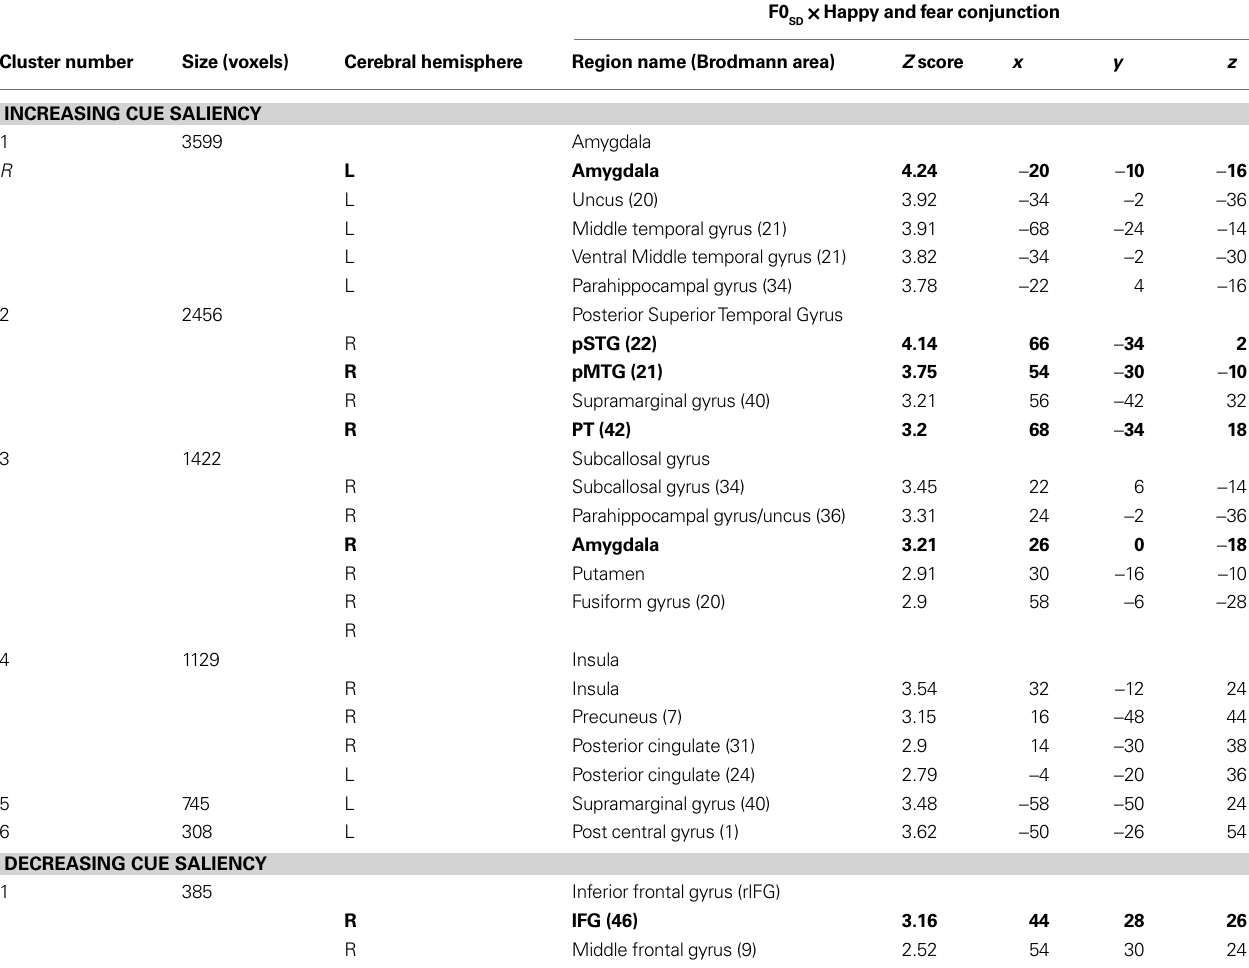
× Happy and fear F0 SD